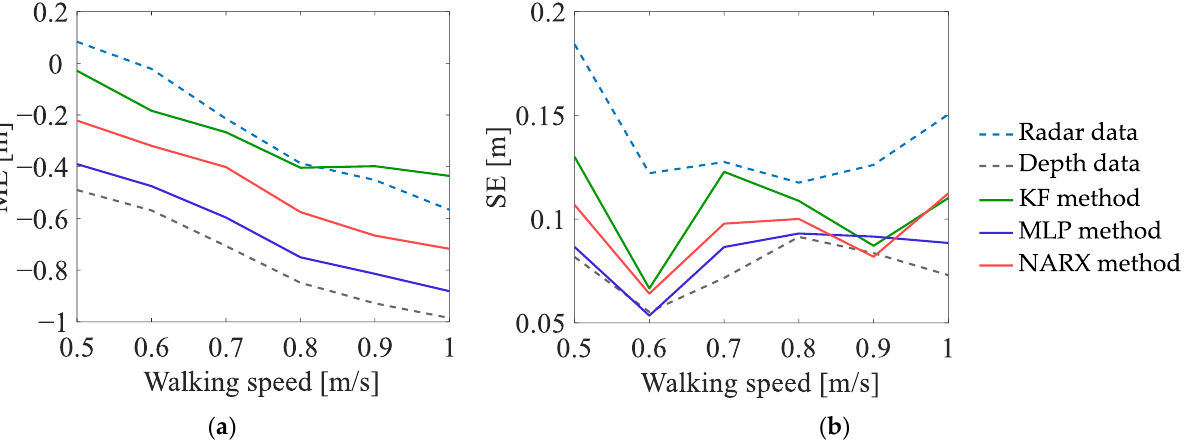
Figure 11. Uncertainty indicators characterising the estimates of the travelled distance, obtained in EXP#2.